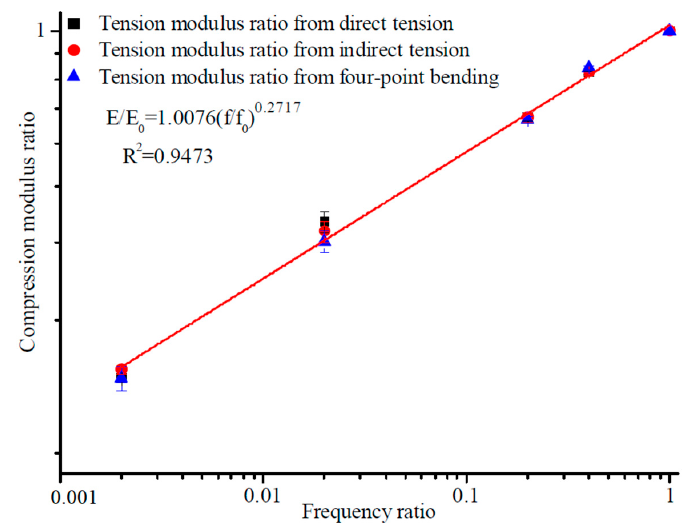
Figure 7. Standardized variation patterns for compression modulus ratio with frequency ratio.